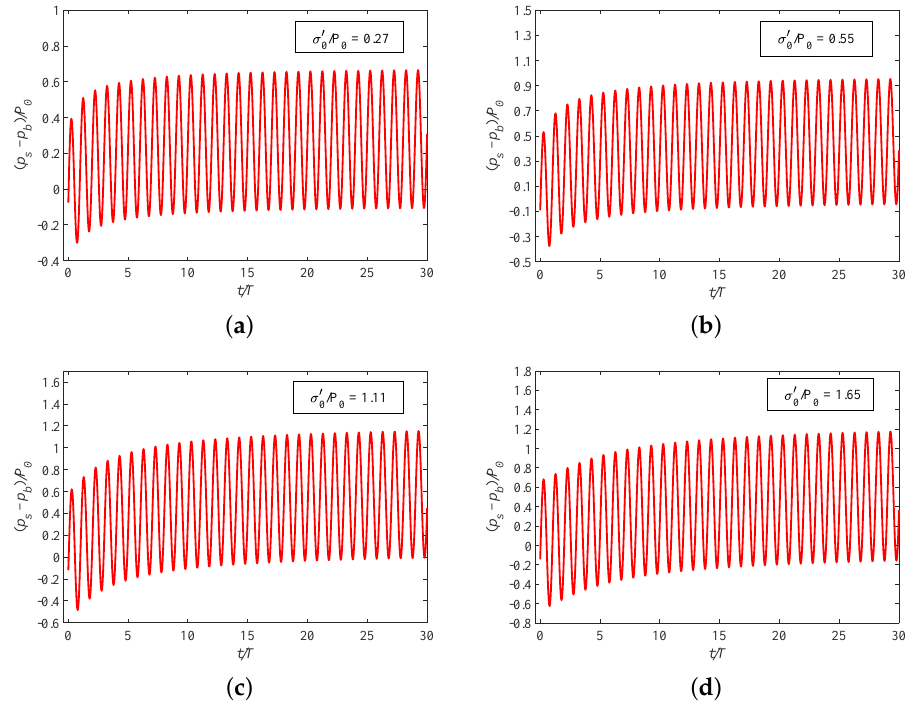
Figure 7. The development of the pore pressure over wave cycle ( t / T ) for Case 1; ( a ) (x,z) = (50.0, − 0.5) m; ( b ) (x,z) = (50.0, − 1.0) m; ( c ) (x,z) = (50.0, − 2.0) m; ( d ) (x,z) = (50.0, − 3.0)